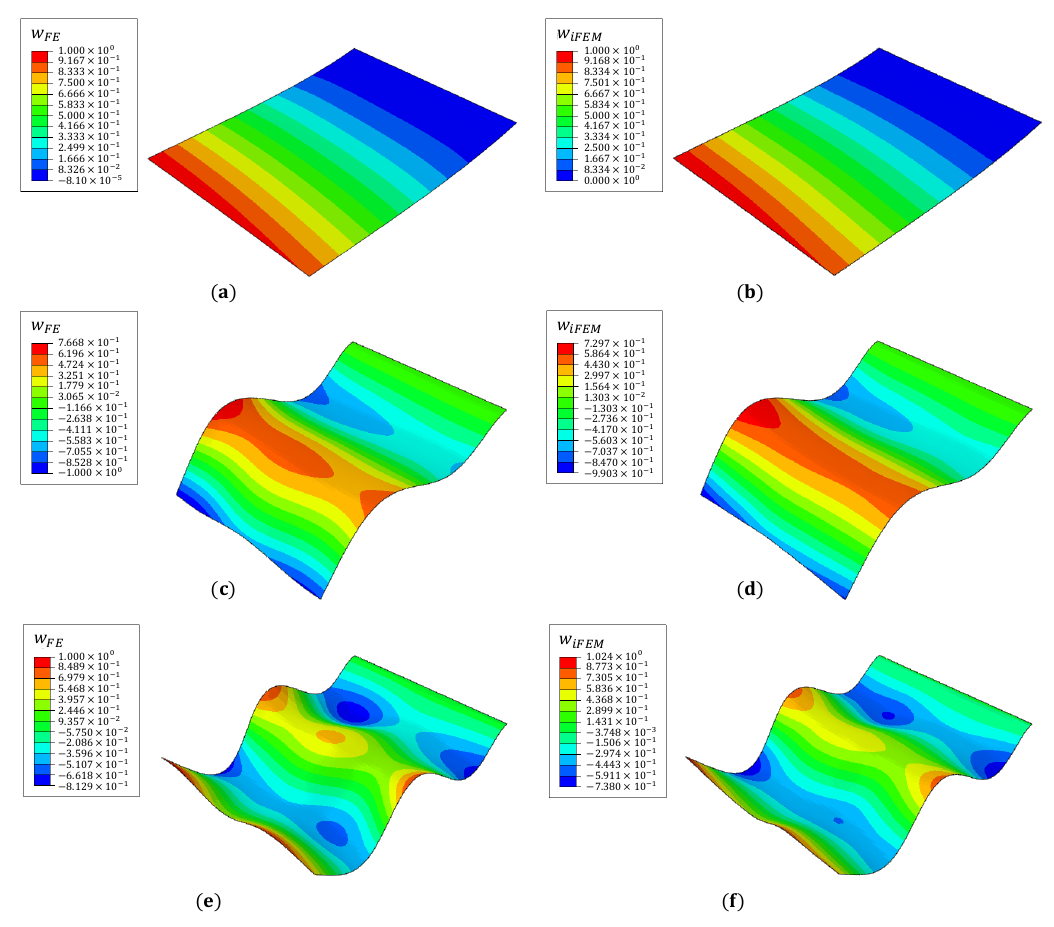
Figure 4. Reference FE and reconstructed iFEM mode shapes for ( a , b ) mode 1, ( c , d ) mode 8, and ( e , f ) mode